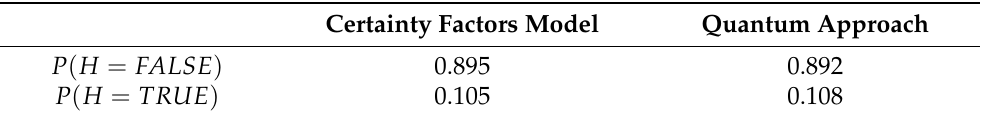
Table 6. Comparison between the results of the a priori probability of the hypothesis H with the classical method and the quantum